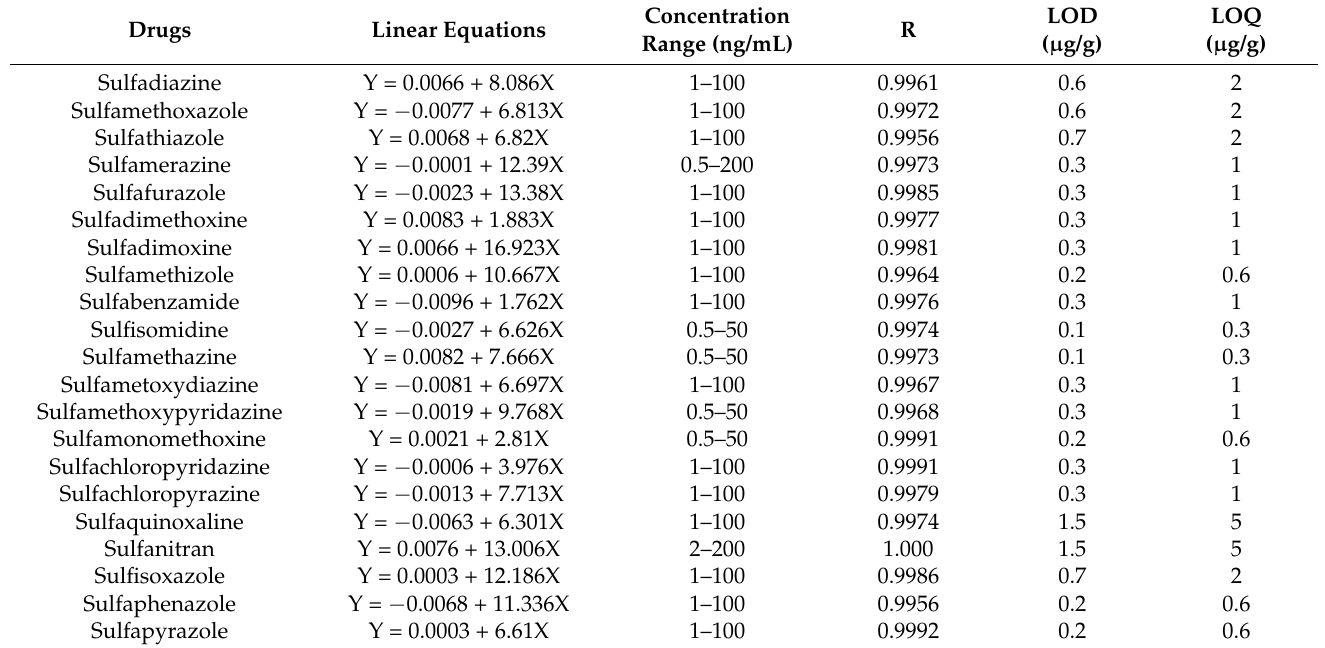
linear regression equation and correlation coefficient (Table 2) revealed that the 21 target compounds had good linear relationships and that the correlation coefficient was not less than 0.990. Table 2. Linear, LOD and LOQ of the developed method.